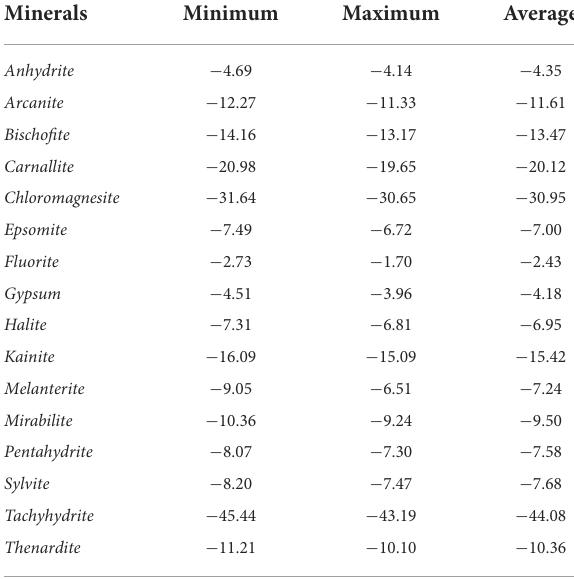
TABLE 2 Representing the mineral saturation indices. Minerals